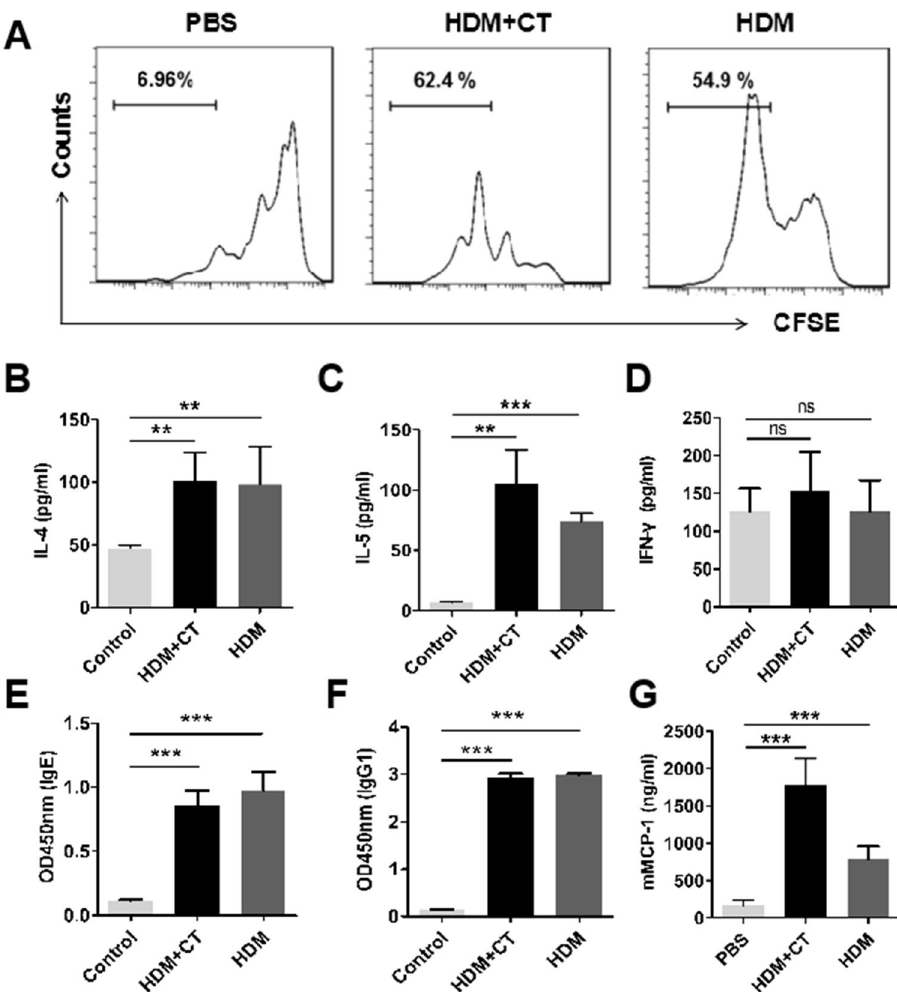
Figure 3. HDM facilitates Th2 immune response. ( A ) the histograms show the proliferation of CD4 + T cells. The bars show the levels of IL-4 ( B ), IL-5 ( C ) and IFN-γ ( D ) in the splenocyte culture supernatant. The level of serum HDM specific IgE ( E ), IgG1 (F) and mMCP-1 (G) were detected by EILSA. Each group consists of 6 mice, * p < 0.05, ** p < 0.01, *** p < 0.001, (ANOVA) compared to the control